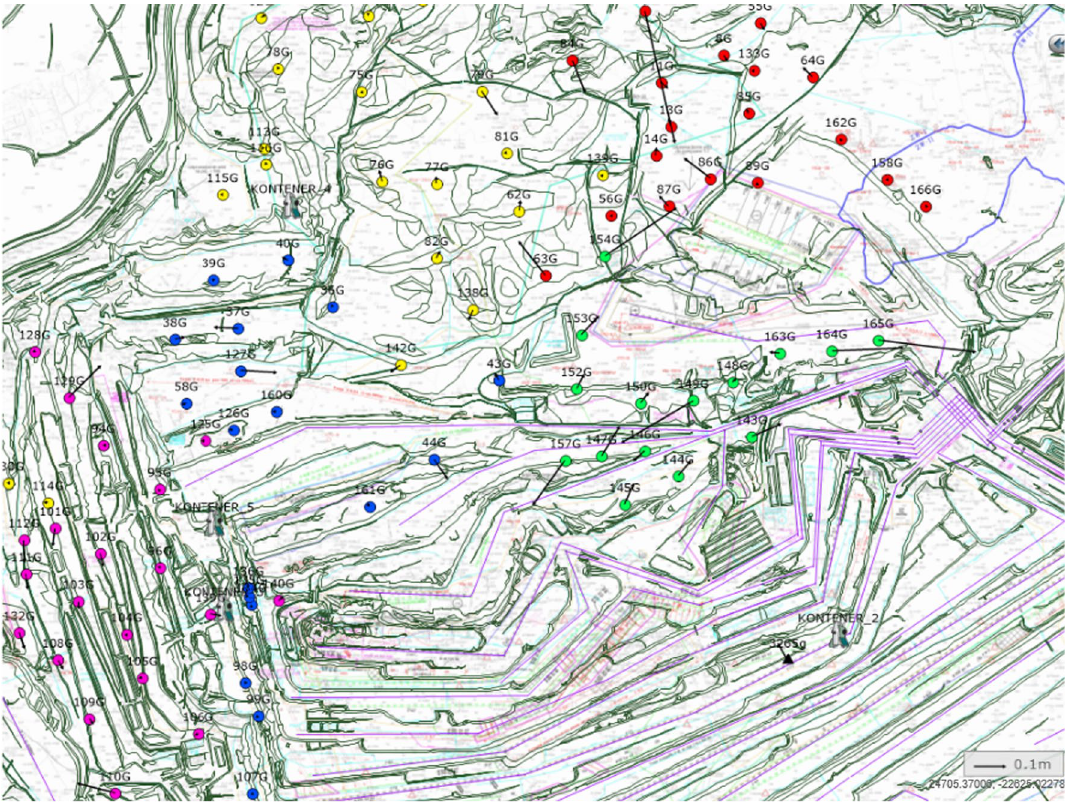
Fig. 4 Visualisation of surface displacement results in GeoMoS